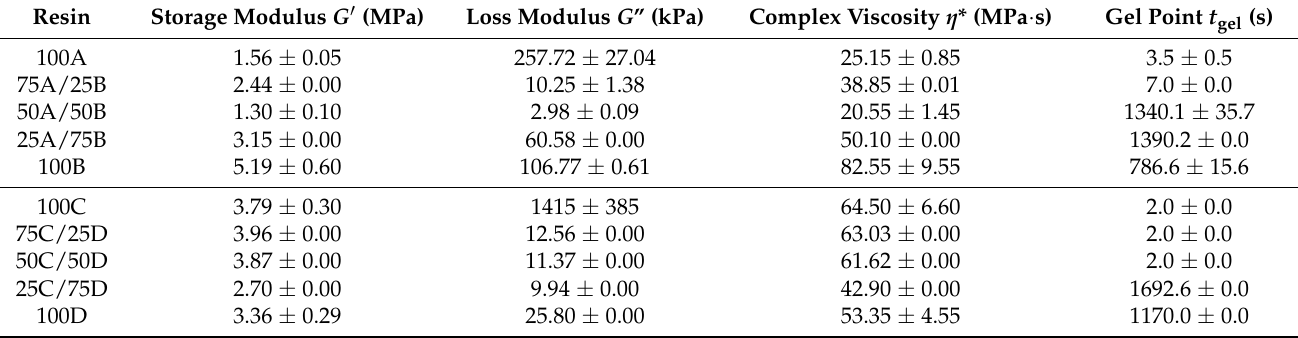
Table 3. Rheological characteristics of vegetable oil-based thiol-ene/thiol-epoxy mixtures. Resin Storage Modulus G (cid:48)